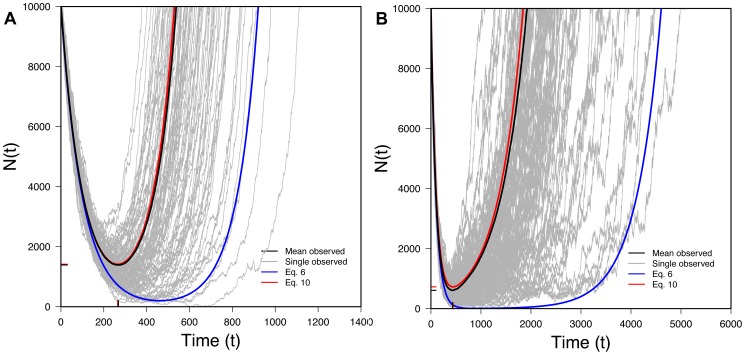
The U-shaped trajectory for populations rescued from standing variation.100 randomly selected successful realizations in gray, mean of all successful realizations in black, Eq. 6 (without the oversampling correction) in blue, Eq. 10 (with the oversampling correction) in red. Ticks on X-axis represent observed (black) and predicted (red) tmin (Eq. 13) while ticks on the Y-axis represents observed (black) and predicted (red) Nmin (Eq. 14). A) N0 = 10,000, r = 0.01, s = 0.02, k = 1; B) N0 = 100,000, r = 0.01, s = 0.02, k = 1; 100,000 realizations.